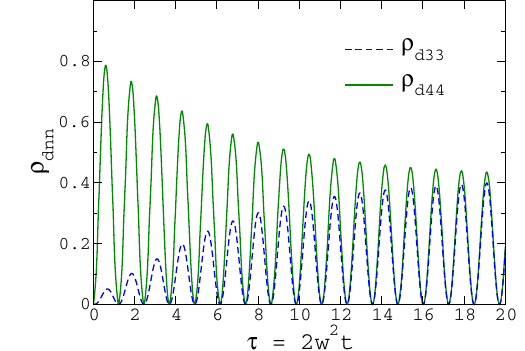
Fig. 8 The same as in Fig. 7, but for ρ d 44 and ρ d 33